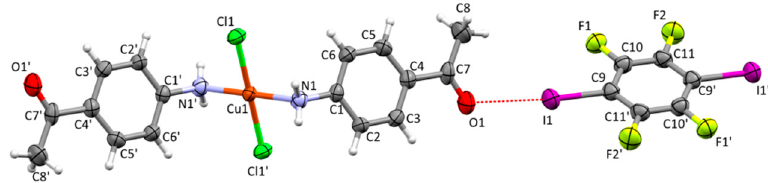
Figure 3. Molecular structure of [CuCl 2 ( aap ) 2 ]( 14tfib ) showing the atom-labelling scheme. Displacement ellipsoids are drawn at a 50% probability level, and H atoms are shown as small spheres of arbitrary radius (See ESI, Table S4, for the symmetry codes of symmetry equivalent atoms marked with an ' symbol).